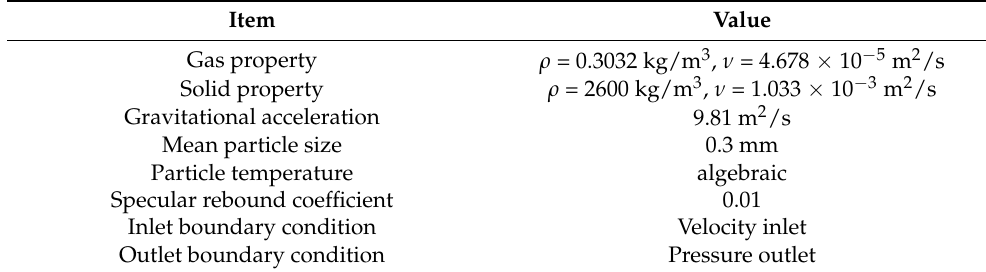
Table 1. Boundary conditions and